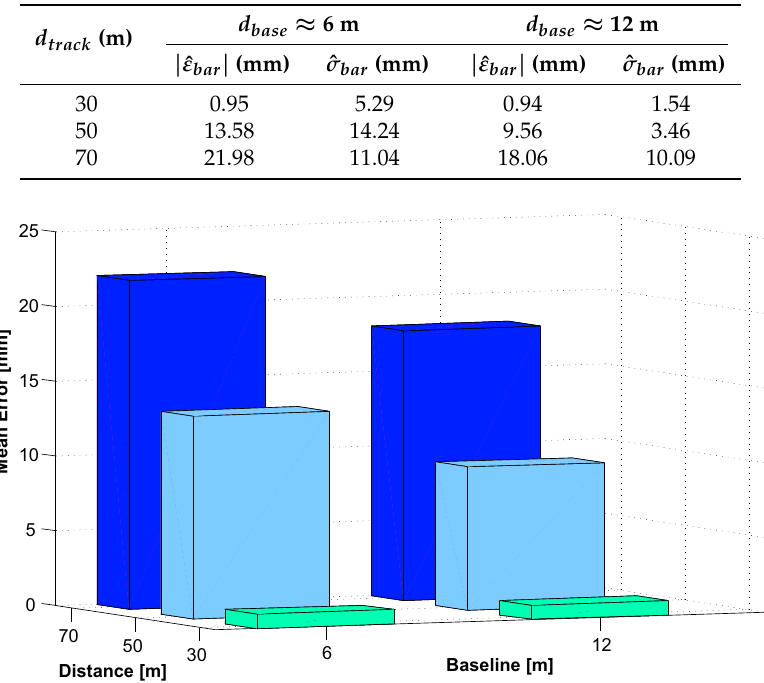
Table 2. Deviations and error of d bar .